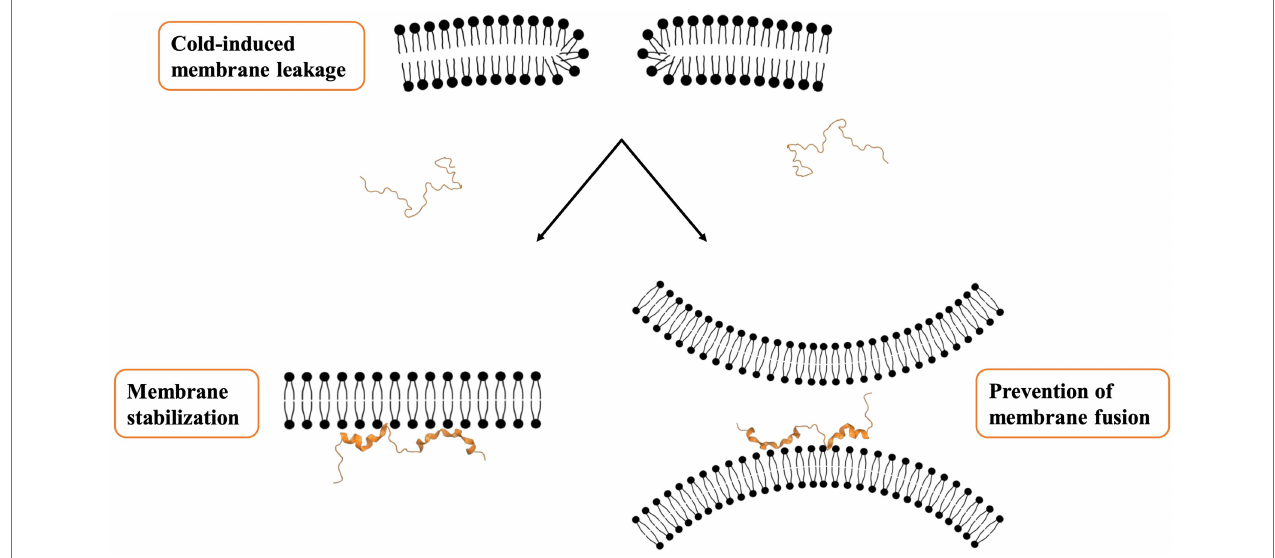
FIGURE 1 | Proposed mechanism for membrane protection. The binding of dehydrins to a biological membrane appears to have two protective effects. One is to maintain membrane fluidity at low temperatures, while the second is to prevent membranes from fusing, either by maintaining the fluidity or by helping to keep them spaced